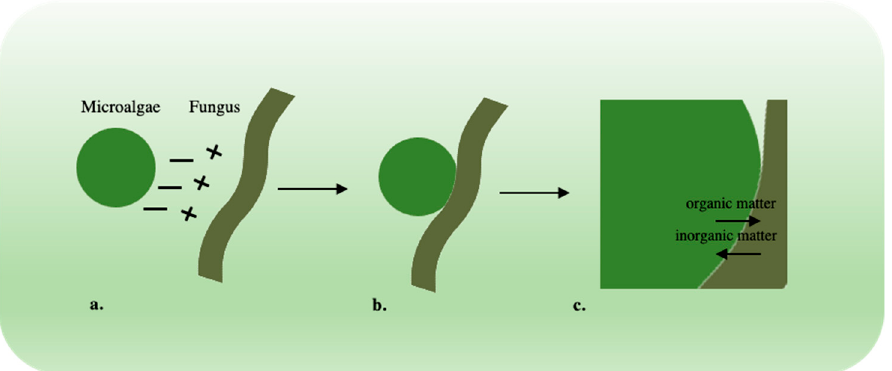
Figure 2. ( a ). Interaction between microalga (negative charge) and fungus (positive charge); ( b ). microalga entrapped among fungal hyphae; ( c ). nutrients exchange between microalga and fungus.